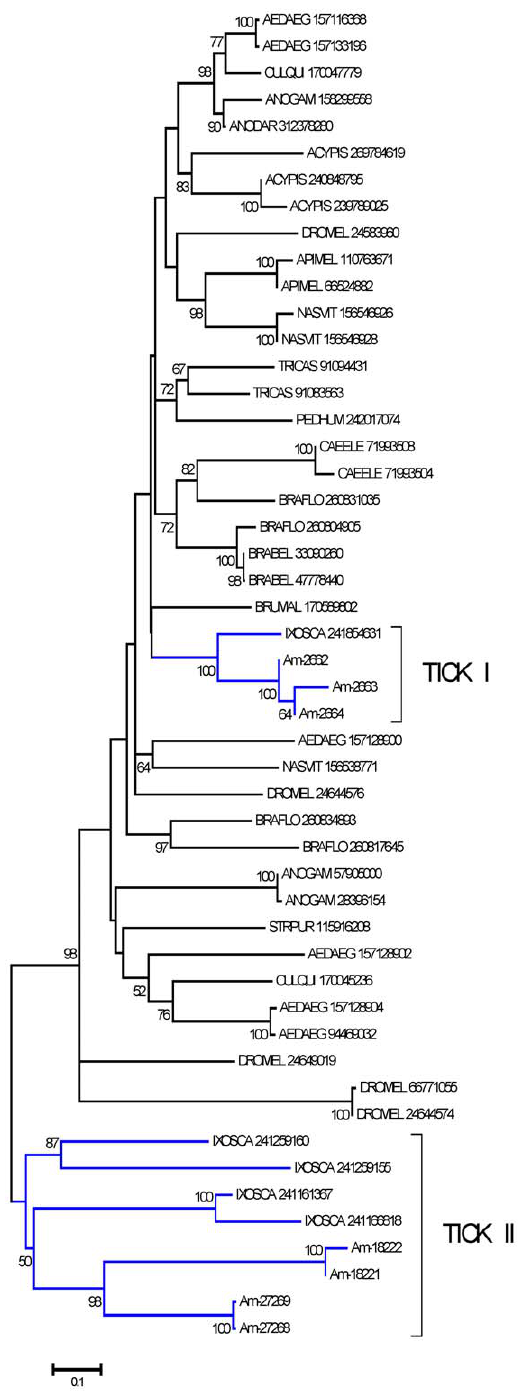
Figure 4. Phylogram of the phosphatidylethanolamine binding protein (PEBP) family of selected arthropods. The bootstrapped phylogram (1,000 iterations) was obtained from the alignment of deducted Amblyomma maculatum proteins with homologs found in the non-redundant protein database of the NCBI. The Am. maculatum protein names start with Am- and the remaining proteins are named by the first three letters of the genus name followed by the first three letters of the species name followed by their NCBI gi| accession number. The number at the nodes indicates the bootstrap support, and the bar at the bottom indicates 10% amino acid divergence. Two tick clades are indicated by Roman numerals.